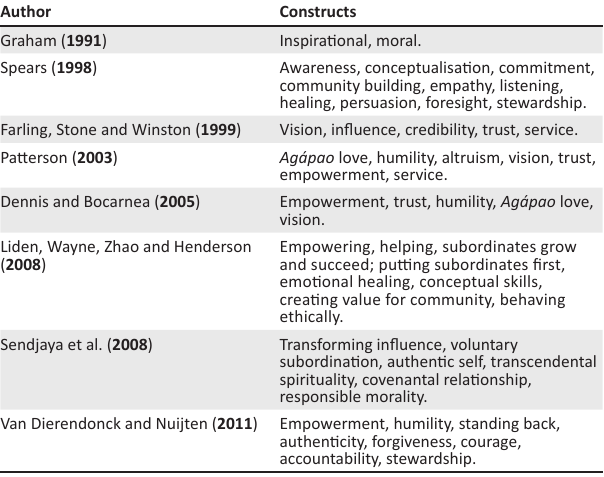
TABLE 1 : Servant leadership – Dominant evolutionary